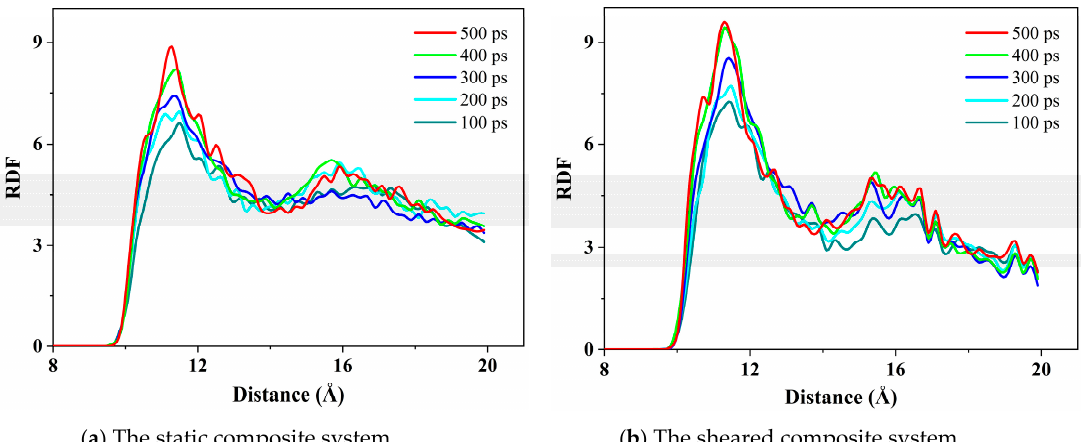
Figure 8. RDF of carbon atoms in PE chains along the CNT radial direction.